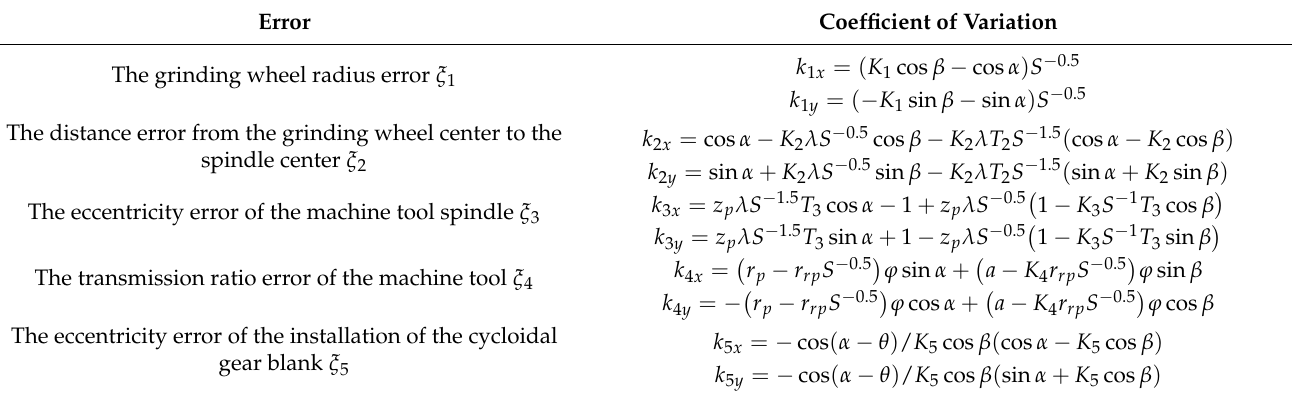
Table 1. Variation coefficient of the machining error on the tooth profile. Error Coefficient of Variation